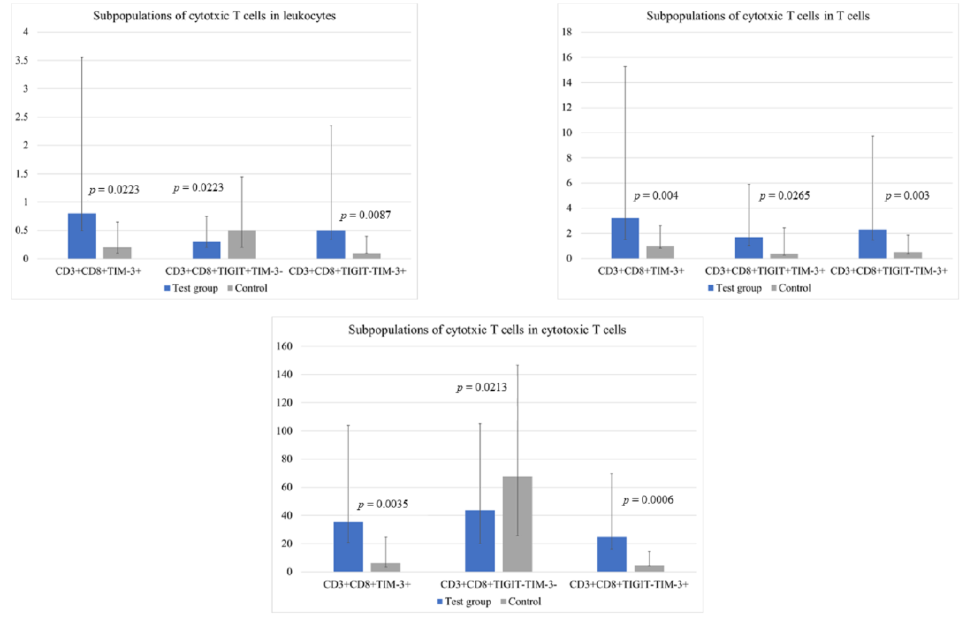
Cells 2023 , 12 , 856 Figure 5. Bar graphs illustrating significant differences between groups in the percentage of certain subpopulations of cytotoxic T cells in the entire population of leukocytes, T cells, and cytotoxic T cells.